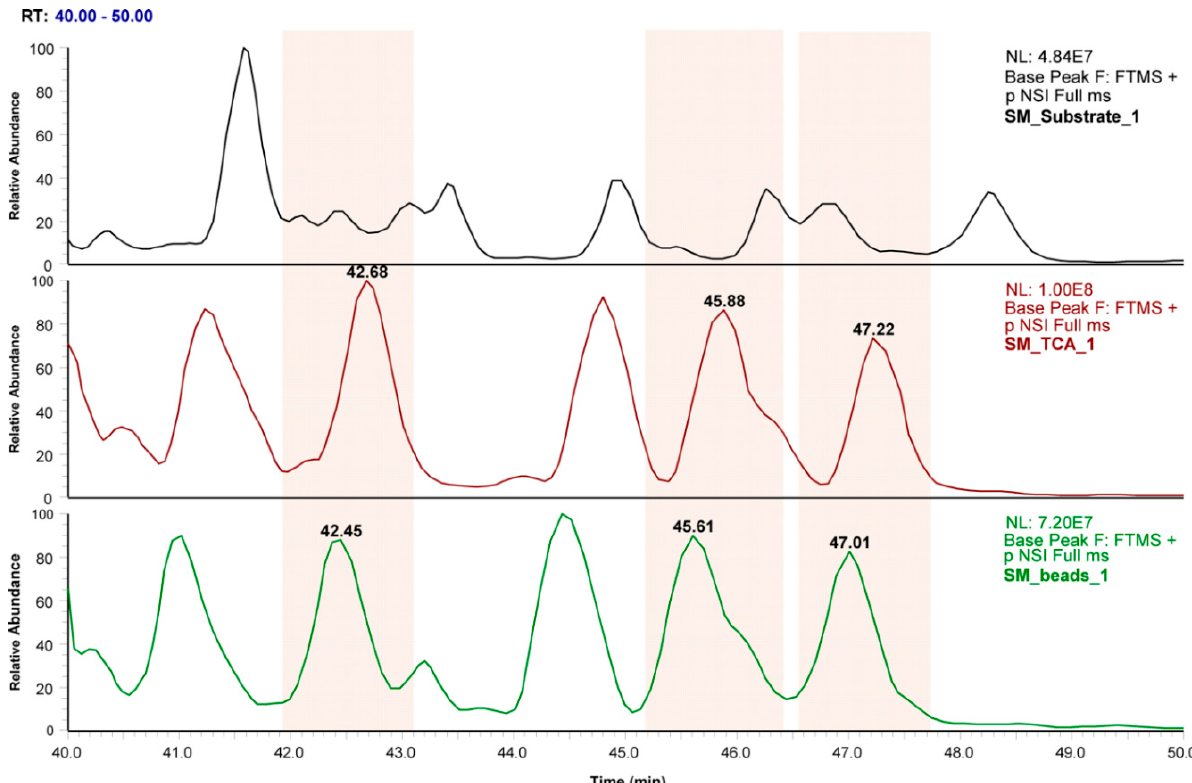
Figure 5. TIC (total ion current) zoomed-in the separative gradient interval 40-50 min of SM-Substrate, SM-TCA, and SM-Beads samples acquired in DDA mode. The light red squares highlight the peaks of interest.